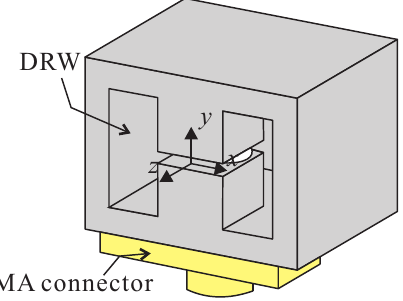
Figure 1. 3D view of an adaptor with a double-ridged waveguide